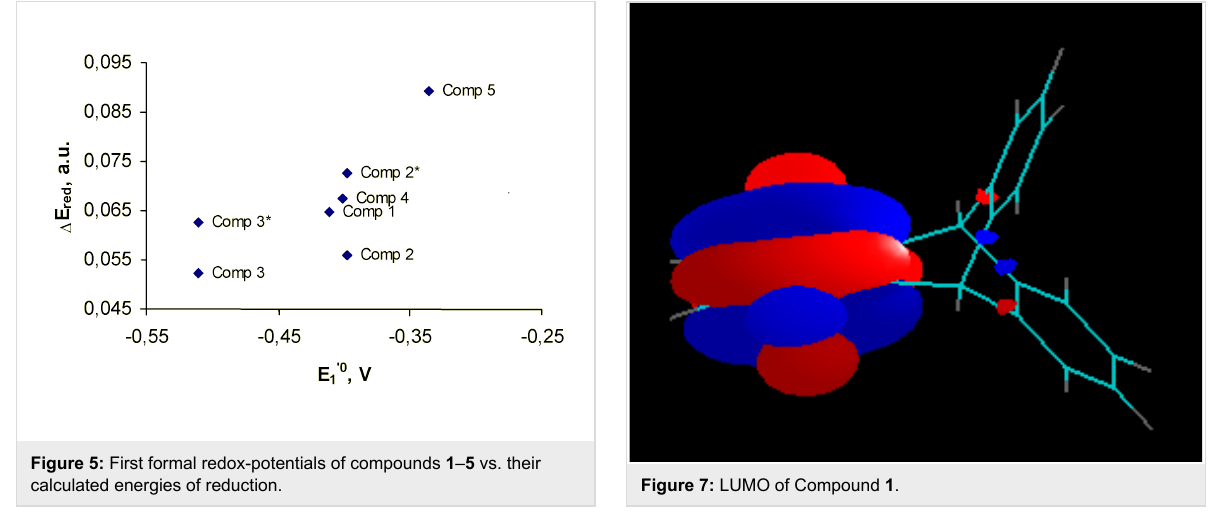
Due to the Mobius-type transannular orbital overlap in the triptycene-quinone system, each π-orbital of the quinone ring (which is always anti-symmetric with respect to the plane of the ring) may interact only with out-of-phase combinations of the group orbitals of the other two benzene rings. Conversely, inter- actions of the π-quinone orbitals with the in-phase combina- tions (they have slightly lower energies, than the out-of-phase combinations and are likely to contribute to the next lower energy molecular orbital) are not allowed by symmetry. This situation is clearly illustrated by the comparison of the calcu- lated LUMO of the triptycene-quinone 1 , lacking noticeable contribution from the non-quinone π-system of the molecule (Figure 7), and the LUMO+1, heavily weighed on the non- quinone benzene rings due to the involvement of the out-of- phase combination of their π-orbitals (Figure 8). Additionally, higher LUMO+1 energy matches better with the antibonding orbital energies of the rest of the bicyclic